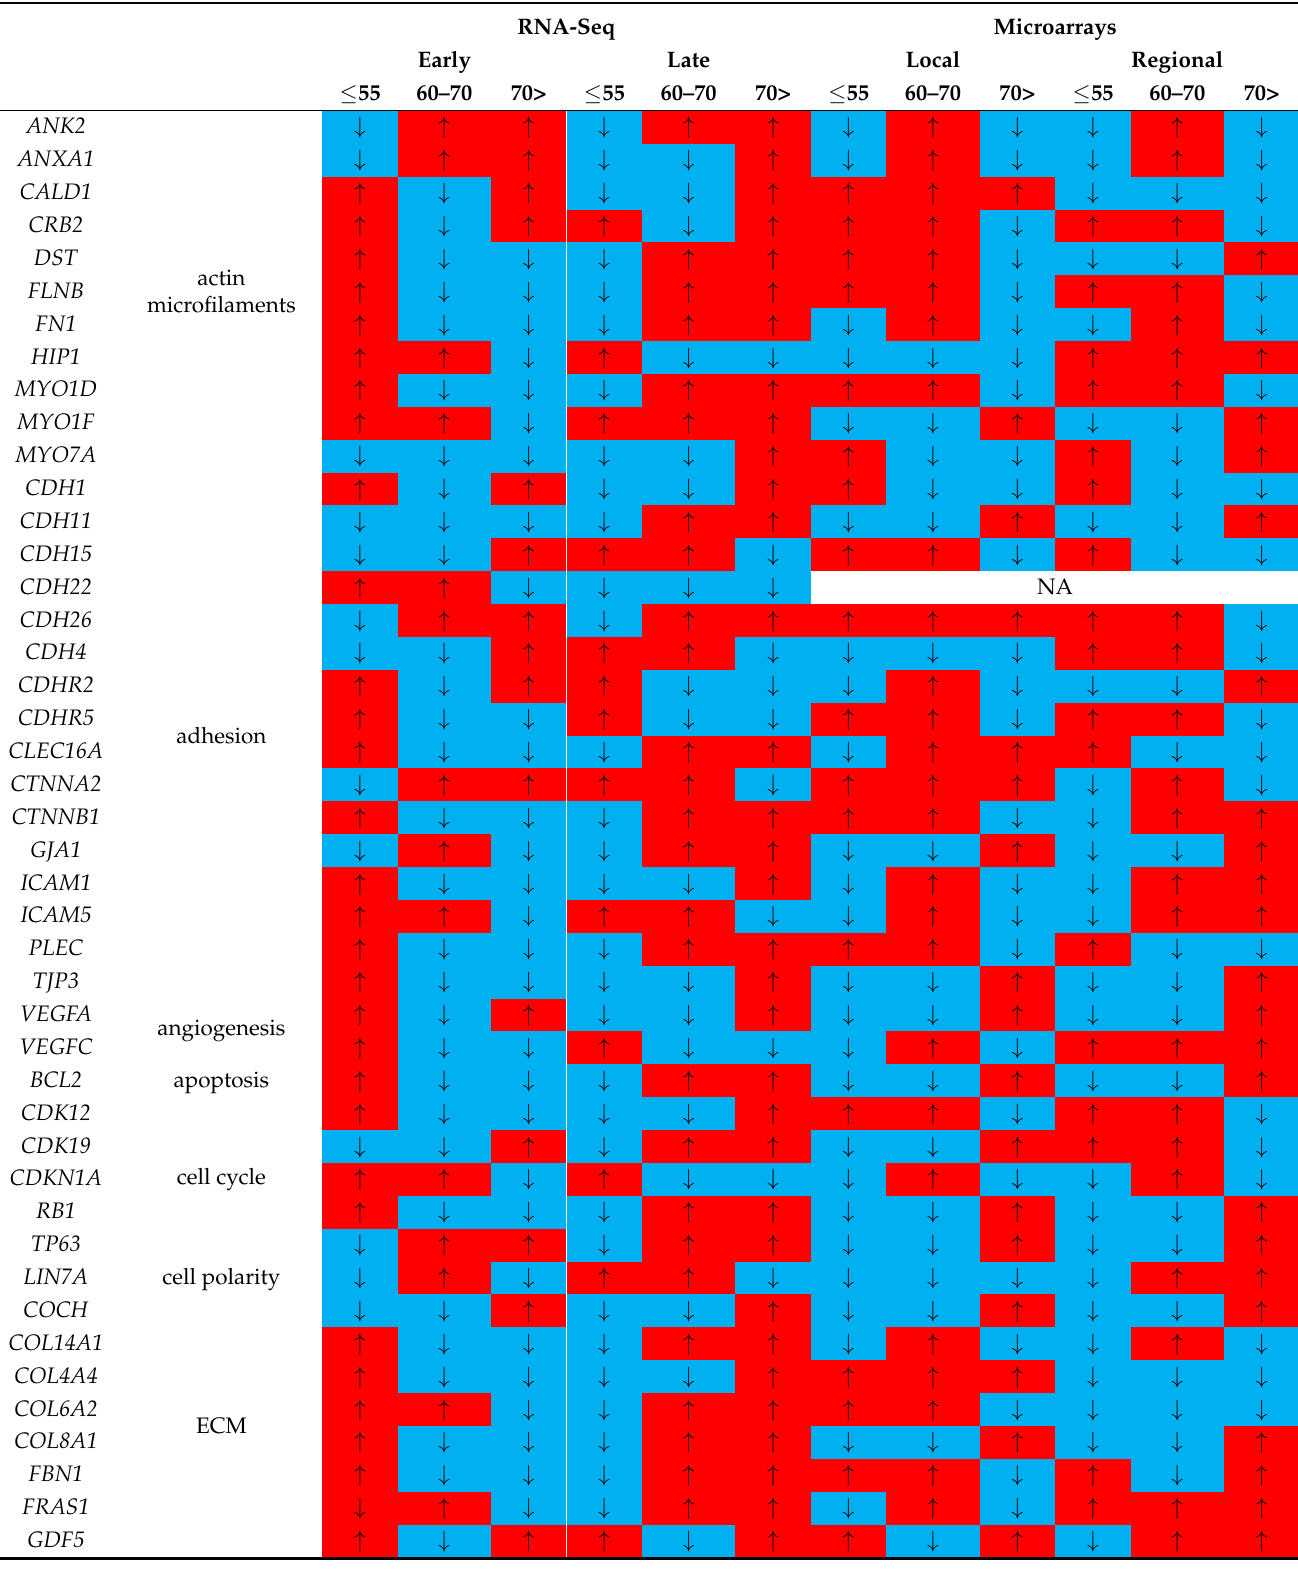
Table 4. Cluster analysis revealed molecular alterations affecting invasive properties of PC driven by the Notch pathway. Blue color and “ ↓ ” indicates downregulation of the expression, red color and “ ↑ ” indicates upregulation of the expression, and NA indicates not available expression profile of a particular gene. All the resulting clusters are available in the Supplementary File